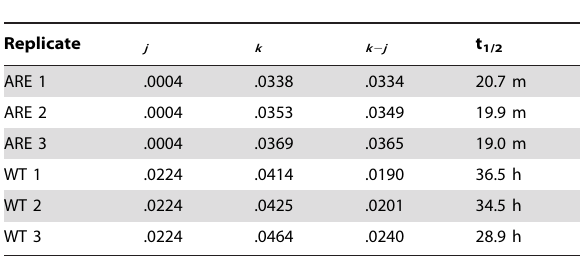
Table 1. Values used in the current